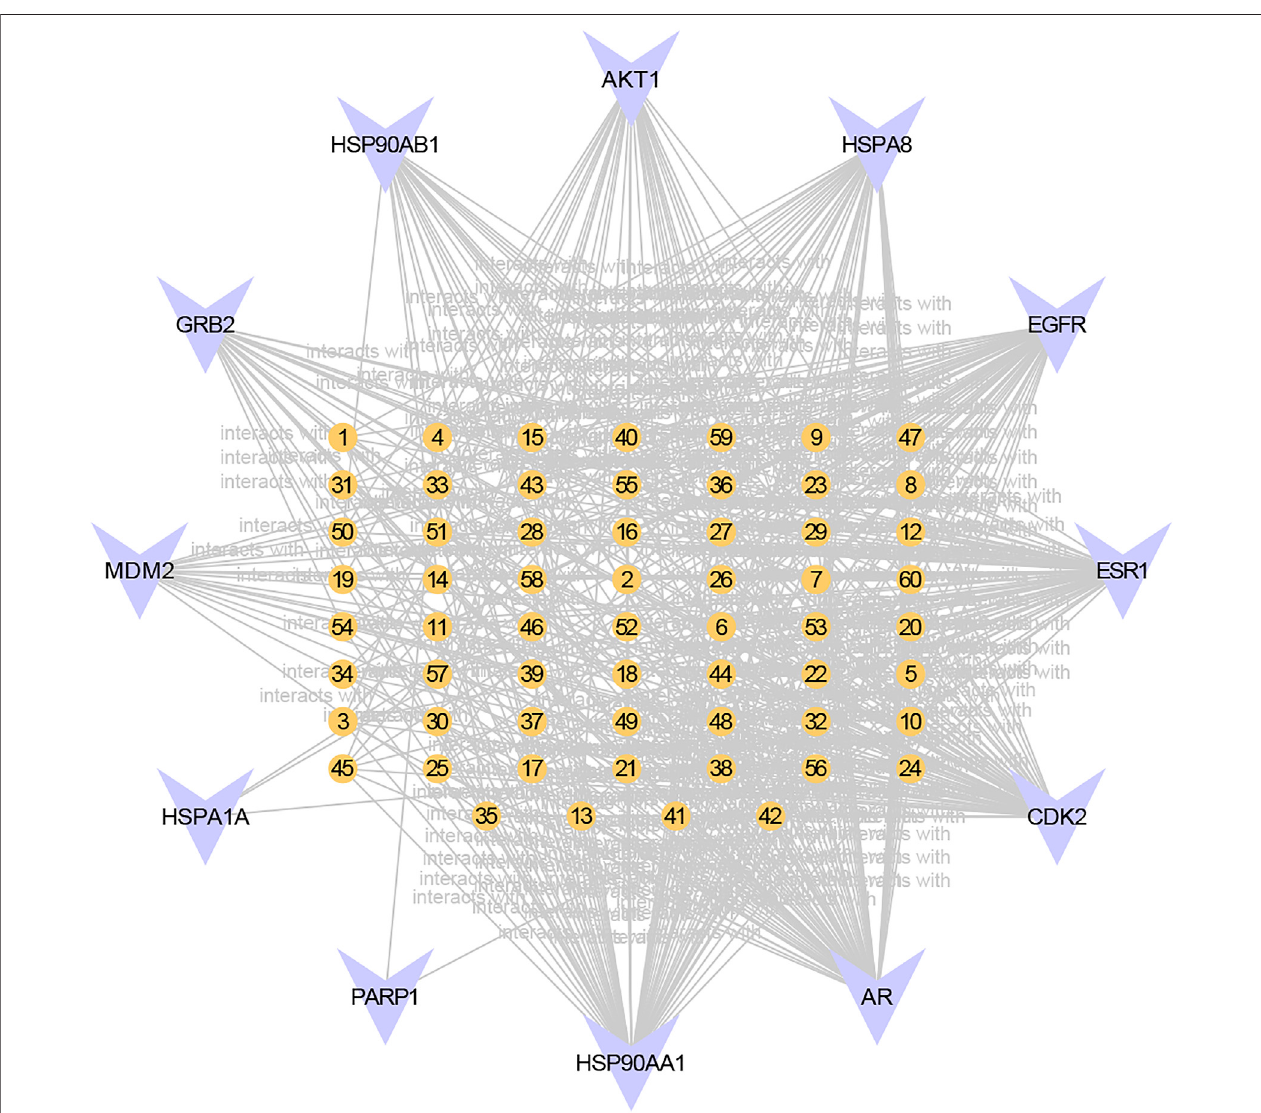
FIGURE 3 | Component-core target network of RC and 12 core targets. 12 of the 126 core targets were RC-targets that correlated with 60 total bioactive components. The orange nodes represent the potential active ingredients, and the violet nodes represent the core targets.